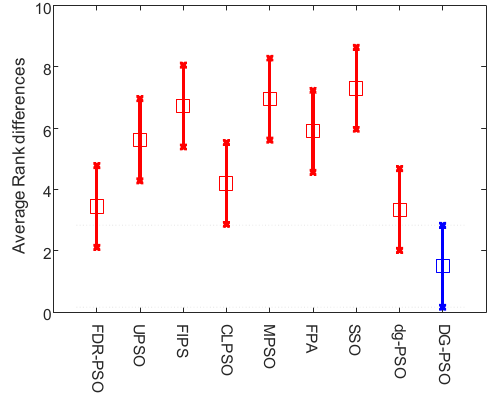
Figure 2. Friedman test of 30D problems.